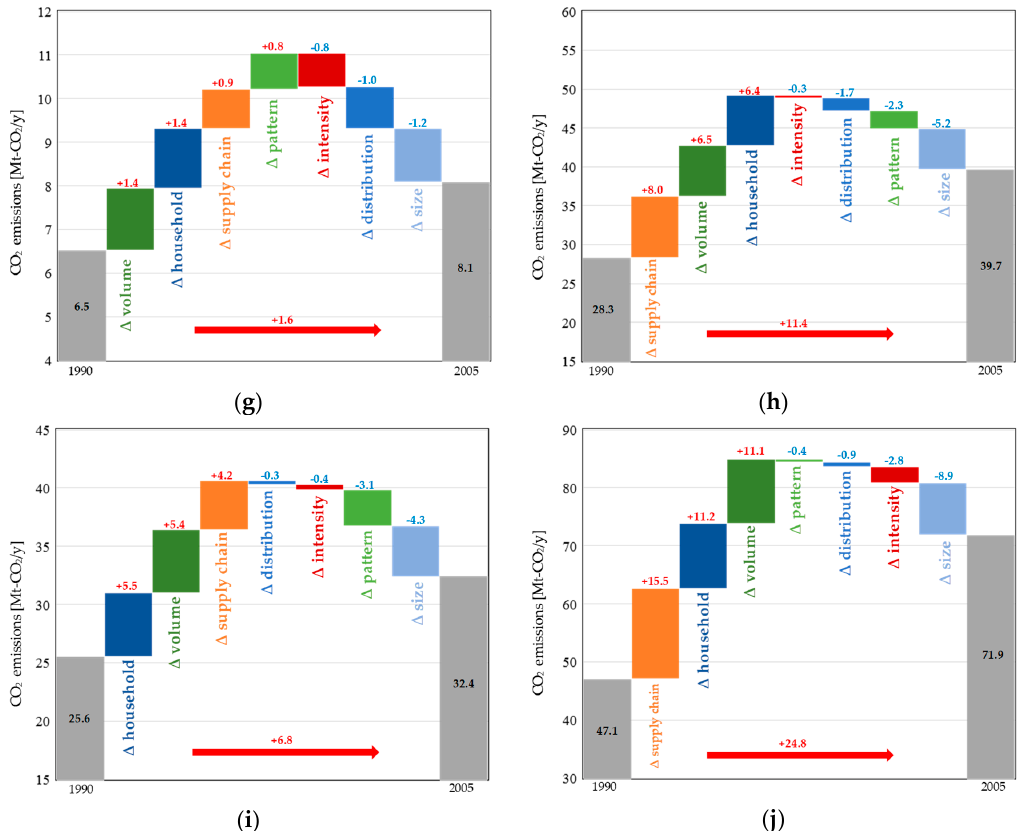
Figure A2. SDA results for indirect CO 2 emissions between 1990 and 2005 for ten sectors not shown in Section 3.3.2. ∆ intensity is intensity effect, ∆ supply chain is the supply chain structure effect, ∆ pattern is the consumption pattern effect, ∆ volume is the consumption volume effect, ∆ size is the household size effect, ∆ distribution is the household distribution effect, and ∆ household is the household number effect. ( a ) Food and non-alcoholic beverages, ( b ) alcoholic beverages and tobacco, ( c ) clothing and footwear, ( d ) furnishings, ( e ) information and communication, ( f ) recreation and culture, ( g ) education, ( h ) restaurants and hotels, ( i ) consumable goods, and ( j ) margins, religions and other